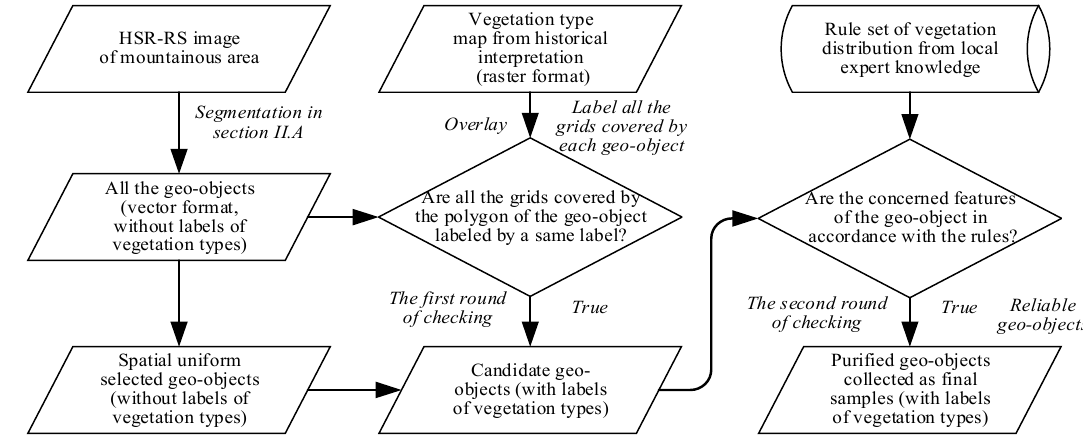
Figure 2. Flow chart of the intelligent collection process of geo-object-based samples with the assistance of historical maps of vegetation types.